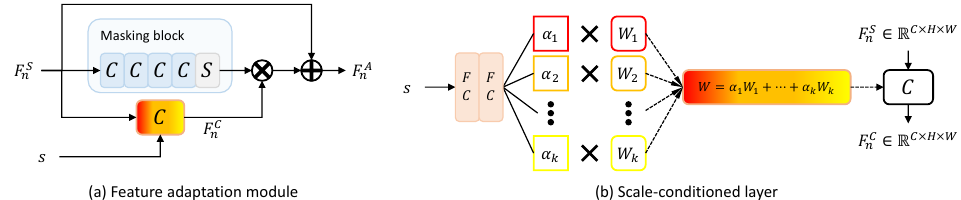
Figure 3. The feature adaptation module and the scale-conditioned layer are illustrated in ( a , b ), respectively. The weights of the convolutional kernel W are calculated by a linear combination of K routing weights and